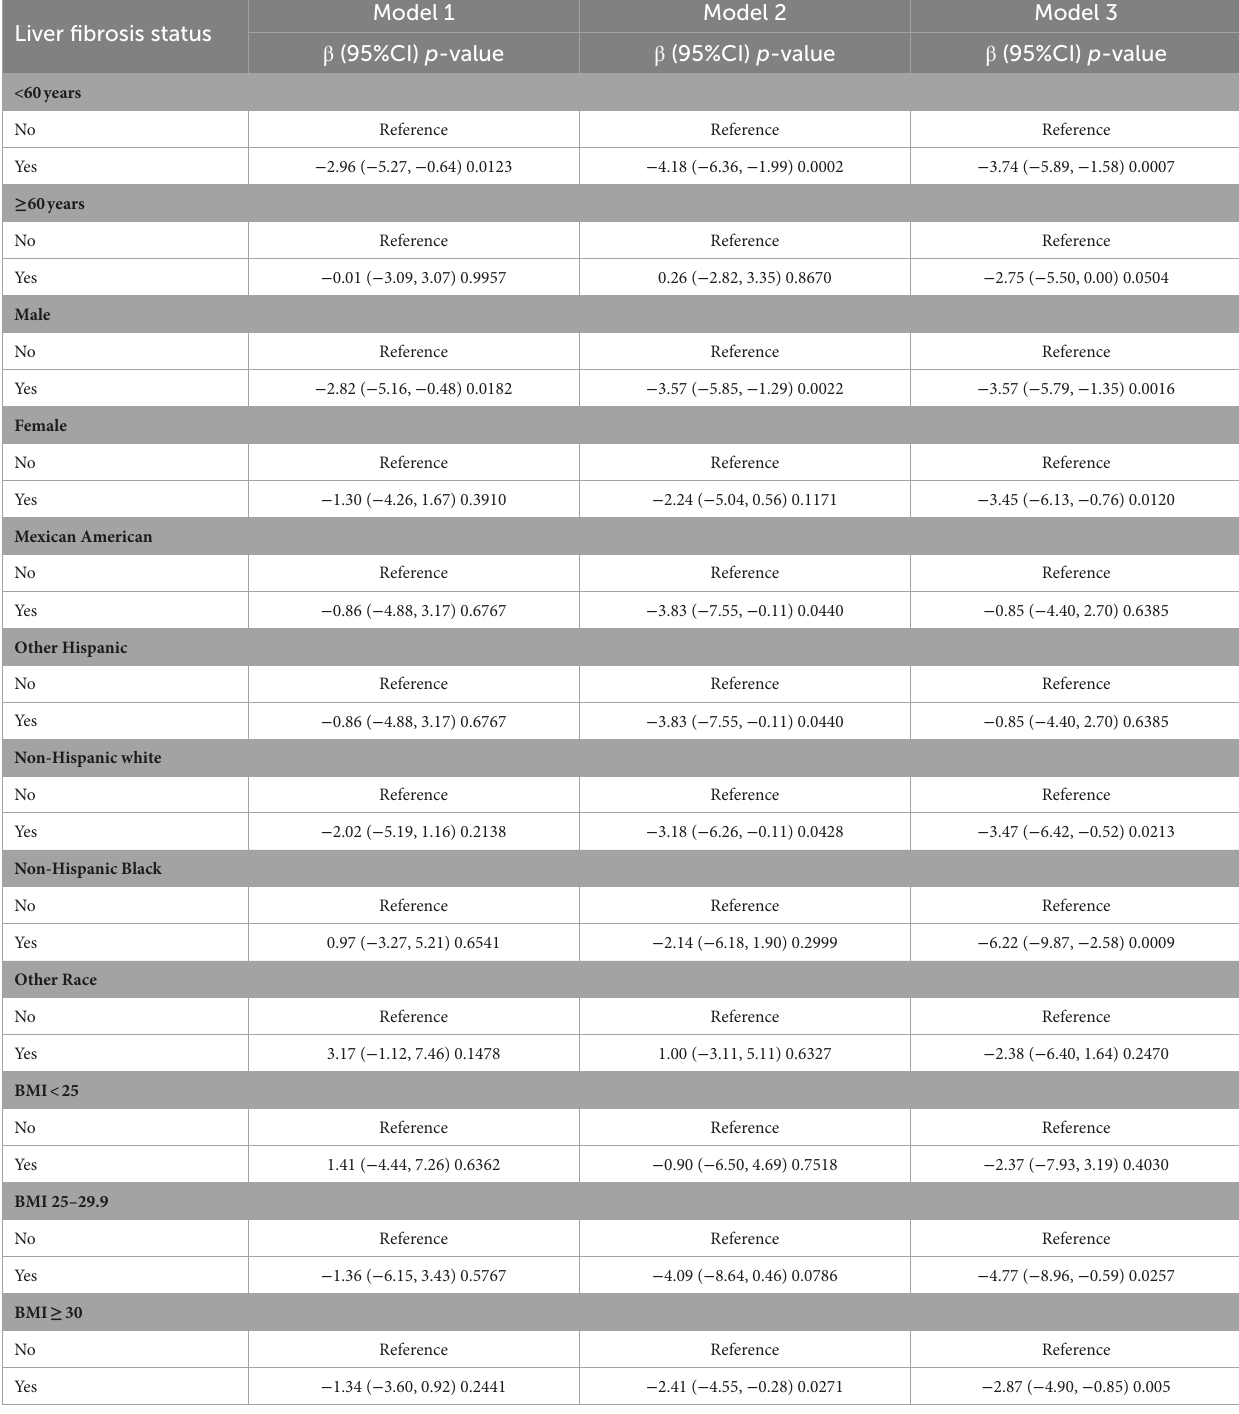
TABLE 4 Relationship between liver fibrosis status and serum retinol ( μ g/dL) in adults, stratified by age, gender, race, and